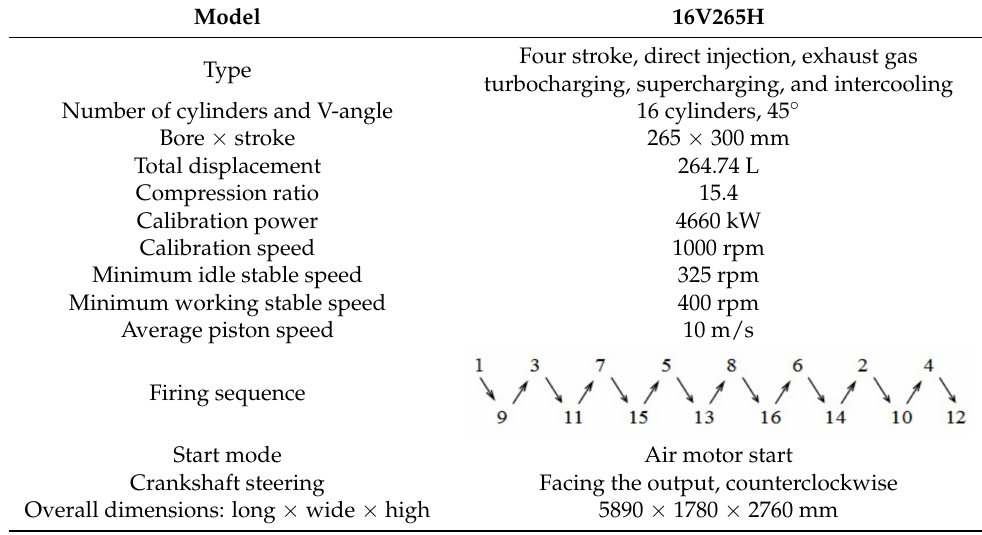
Table 4. The major technique parameters of the 16V265H diesel engine.